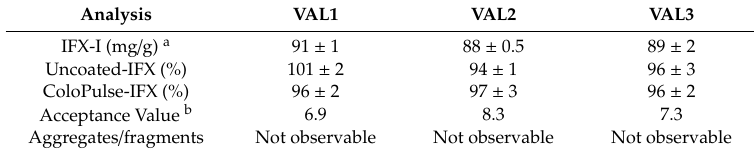
Table 4. The results of the HPLC-SEC analyses of the validation batches (VAL1-3). IFX-I ( n = 3 for each batch) was analyzed to determine the amount of IFX-I needed for 5 mg IFX tablets. IFX content is expressed as percentage of 5 mg for the Uncoated-IFX ( n = 3 for each batch) and ColoPulse-IFX ( n = 10 for each batch) tablets. The acceptance value was calculated according to the Ph. Eur. [56]. Analysis